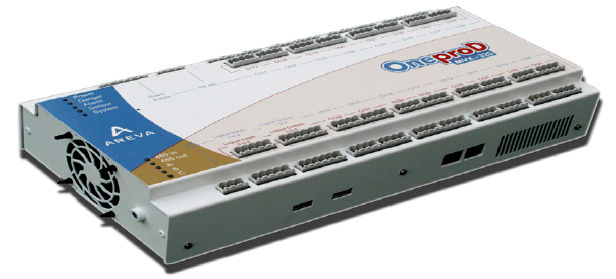
Figure 1 – Monitoring system OneproD – MVX Рис . 1 – Системы мониторинга OneproD – MVX Slika 1 – Monitoring sistem OneproD –